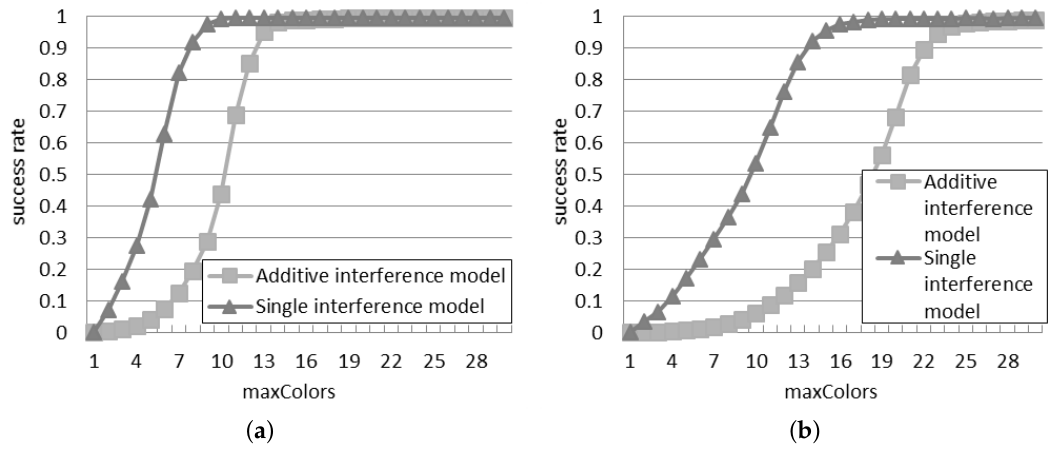
Figure 9. Success rate in the distributed color selection (DCS) scenario: ( a ) 30 readers; ( b ) 50